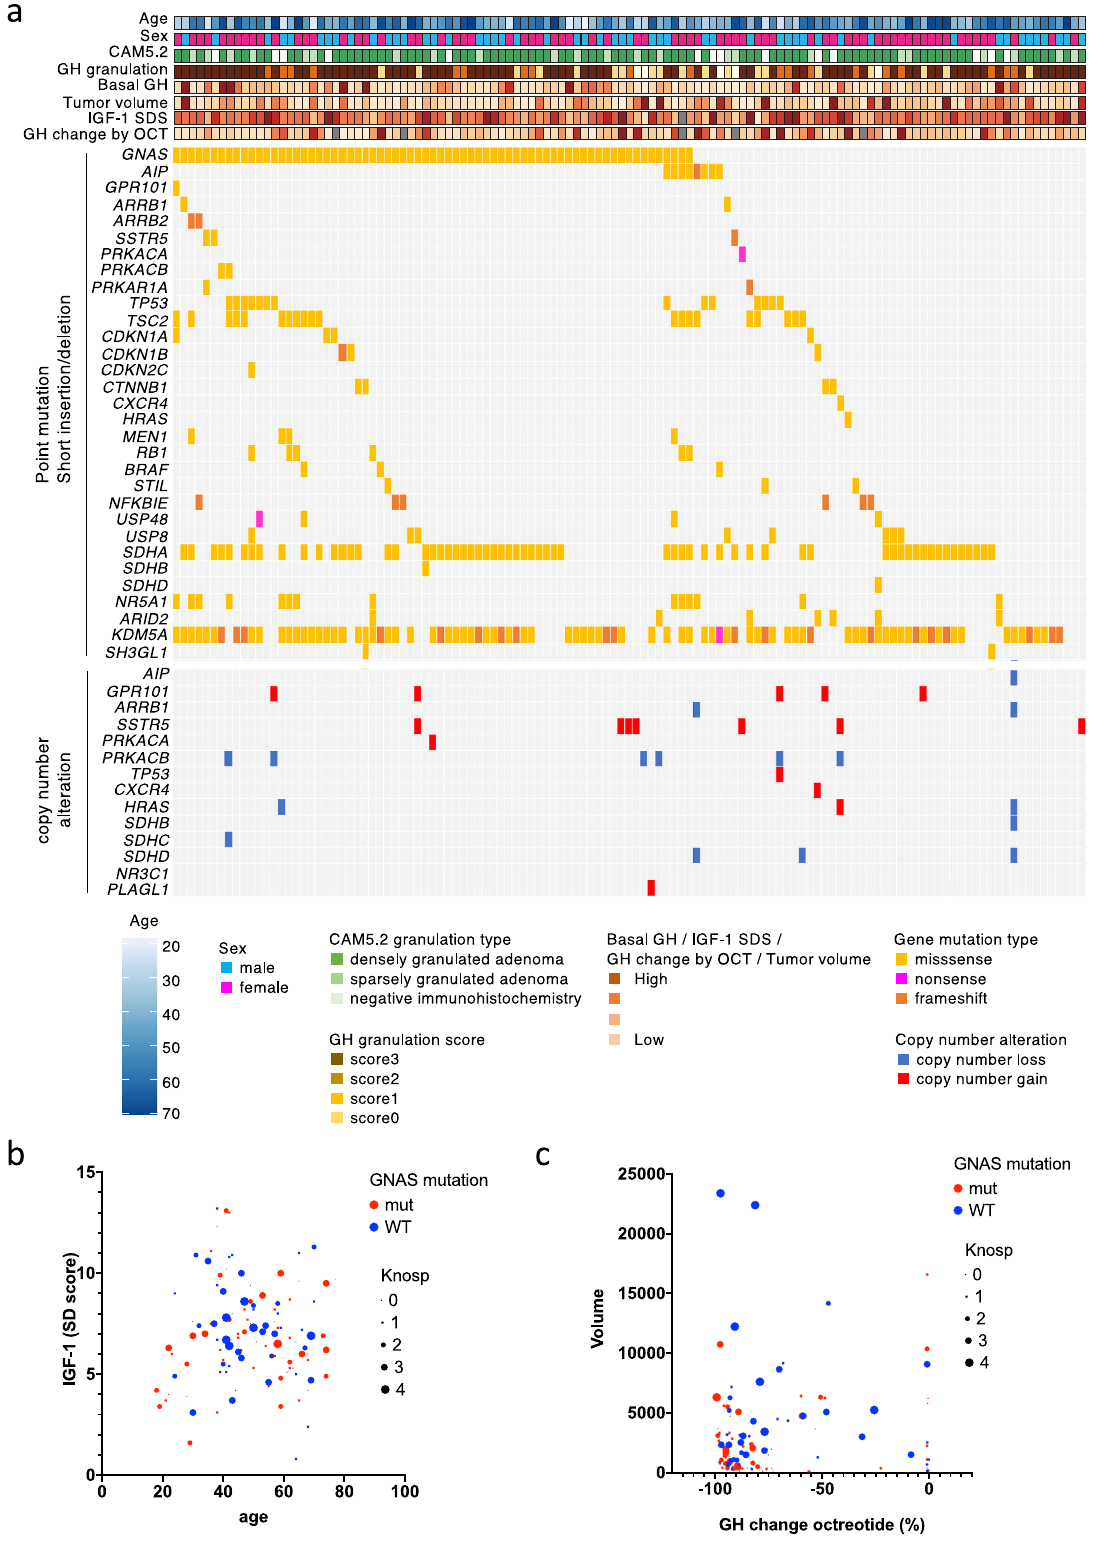
Fig. 1 The landscape of gene mutations and CNAs in GHomas/somatotroph PitNETs. a The landscape of gene mutations and copy number alterations (CNAs) in 121 growth hormone (GH)-producing pituitary adenomas/somatotroph PitNETs obtained by targeted capture sequencing (TCS), together with clinical and pathological annotations. b Bubble plot analysis, with age as the x -axis and the IGF-1 SD score as the y -axis. Blue circles represent GNAS wild- type, and red circles represent GNAS mutations. The circle size is relative to the Knosp grade. c Bubble plot analysis with GH change after octreotide treatment as the x -axis and tumor volume as the y -axis. Blue circles represent wild-type, and red circles represent mutations. The circle size is relative to the Knosp